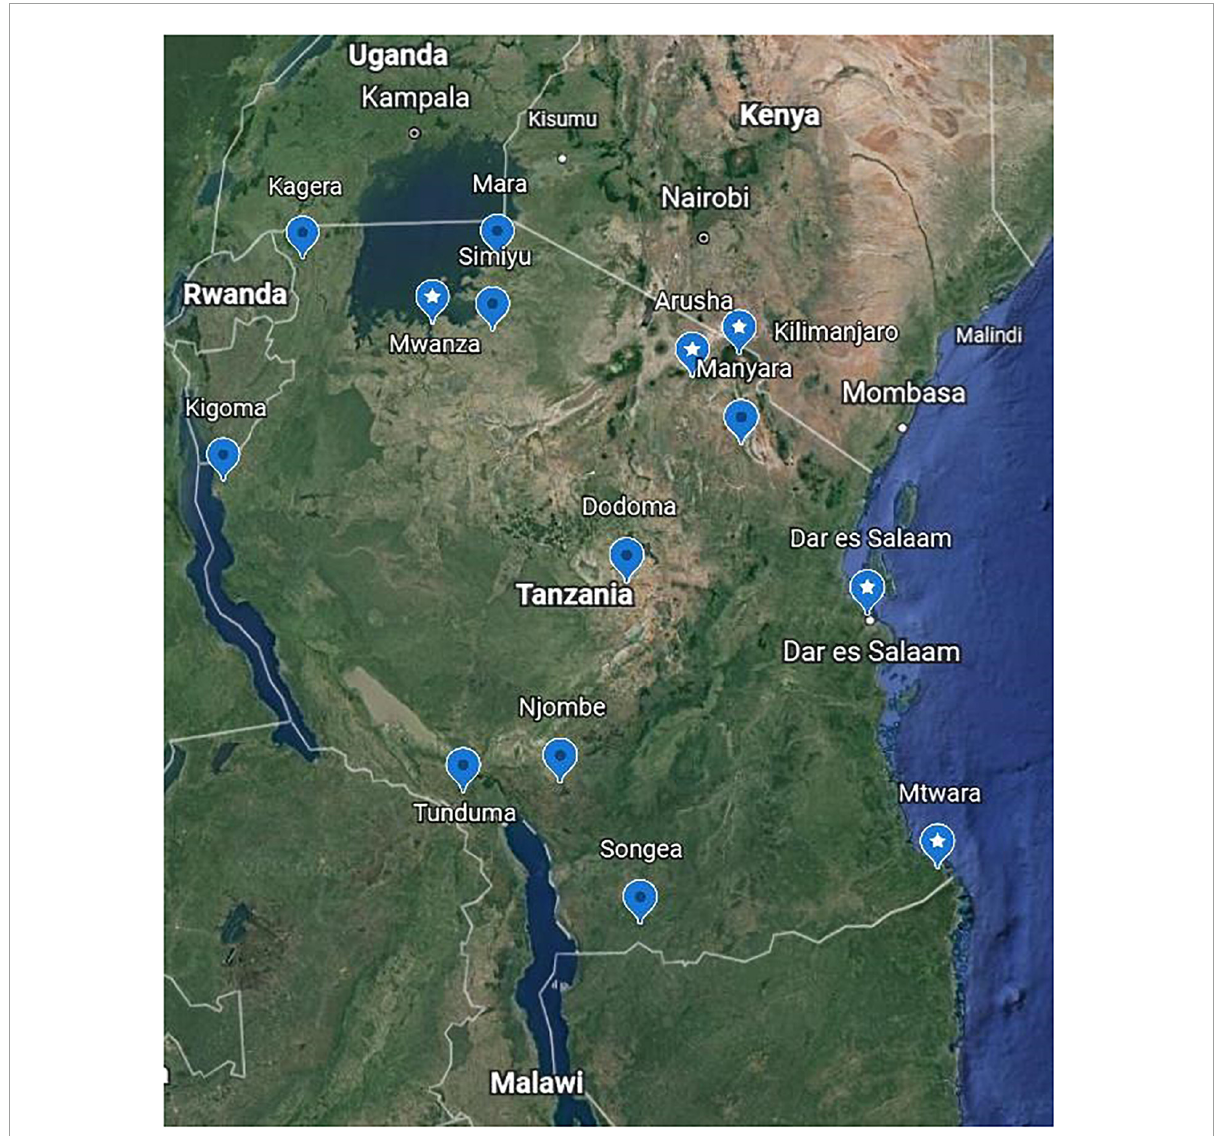
FIGURE1 Sample collection sites. A Google Earth map showing the locations in Tanzania where 69 nasopharyngeal swabs were collected from individuals confirmed with coronavirus disease-2019 (COVID-19) for this study. Labels with star show the locations where the 29 samples that were sequenced originated; these match the place names in Table 2